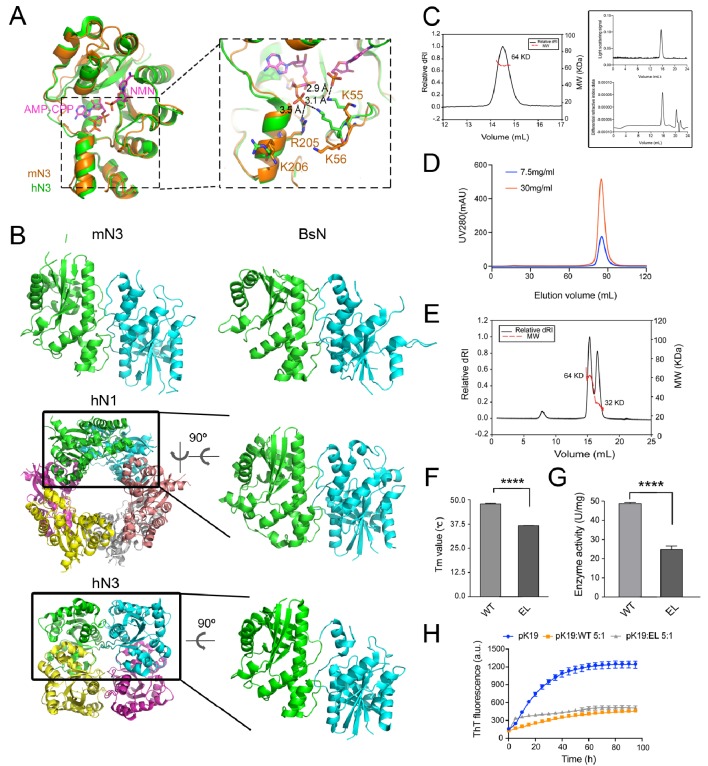
Characterization of mN3 dimer structure and activities.(A) Structure superimposition of mN3 (orange) and hN3 (green, PDB ID: 1NUS). Substrates AMP-CPP (non-hydrolyzable ATP analog) and NMN from the structure of hN3 are shown as sticks in magenta. Positively charged residues that compose the positively-charged patch of mN3 are shown in sticks. Their interactions with the phosphate groups of substrates are labeled in the zoom-in view. (B) Structures of NMNAT proteins. Functional oligomers are shown including dimers of mN3 (PDB ID: 5Z9R) and BsN (1KAM), hexamer of hN1 (1KQN) and tetramer of hN3 (1NUR). The conserved dimer units (green and cyan) are shown in the same orientation. (C) SEC-MALS of mN3. The graph on the left shows the elution profile of mN3 by size exclusion chromatography (smooth trace) and the resulting molecular mass (red dotted line). Raw data of light scattering signal (upper) and dRI (lower) are shown on the right. (D) Size exclusion chromatography of mN3 at indicated concentrations. (E) SEC-MALS of mN3 EL mutant. The resulting molecular mass indicates a mixture of mN3 dimer and monomer in solution. (F) Melting temperature of mN3 WT and EL mutant measured by the DSF assay. The data shown correspond to mean ± s.d., with n = 3. Values are compared using Student’s t-test. ****p<0.0001. (G) Enzyme activities of mN3 WT and EL mutant measured with the NMN concentration of 625 µm. The data shown correspond to mean ± s.d., with n = 3. Values are compared using Student’s t-test. ****p<0.0001. (H) ThT kinetic assay of pK19 (100 μM) inhibited by mN3 WT and EL mutant. The molar ratio of pK19 to mN3 is indicated. The data shown correspond to mean ± s.d., with n = 5.